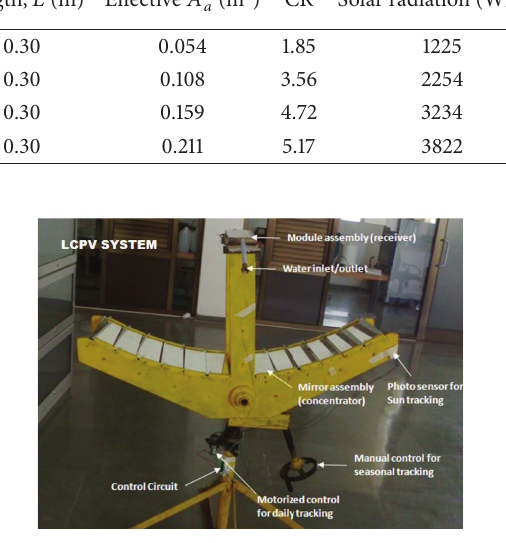
Figure 3: The constructed model of concentrator photovoltaic (CPV)